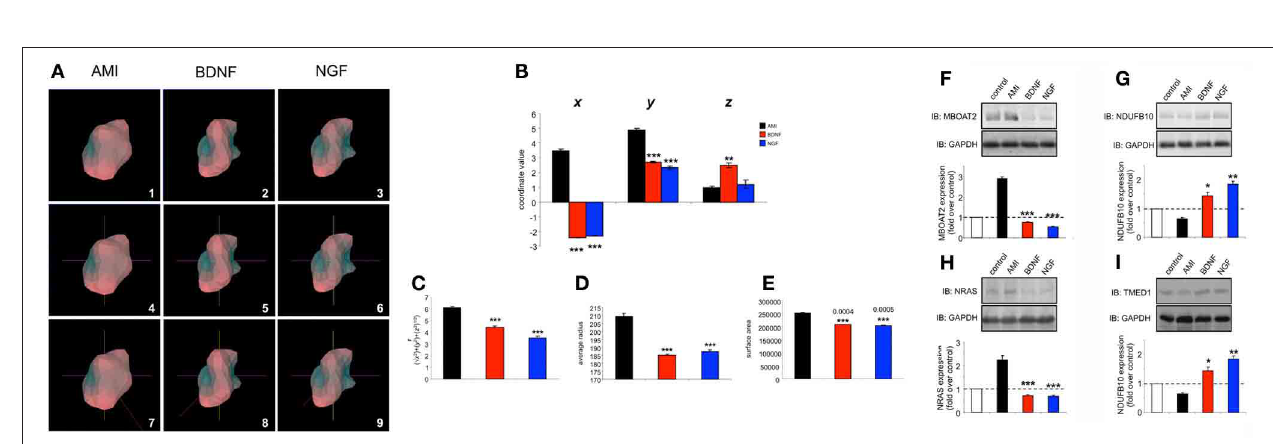
FIGURE 8 | Chronic low-dose peroxide treatment of human neuronal cells differentially affects stimulatory ligand behavior. (A) Venn analysis of significant gene transcriptome regulatory activity for AMI, BDNF and NGF both in control SH-SY5Y neurons (treated with vehicle) and SH-SY5Y neurons previously exposed to 10nM hydrogen peroxide for 7 days (peroxide). The percentage of transcription conservation between control and peroxide states is indicated for AMI, BDNF, and NGF. (B)